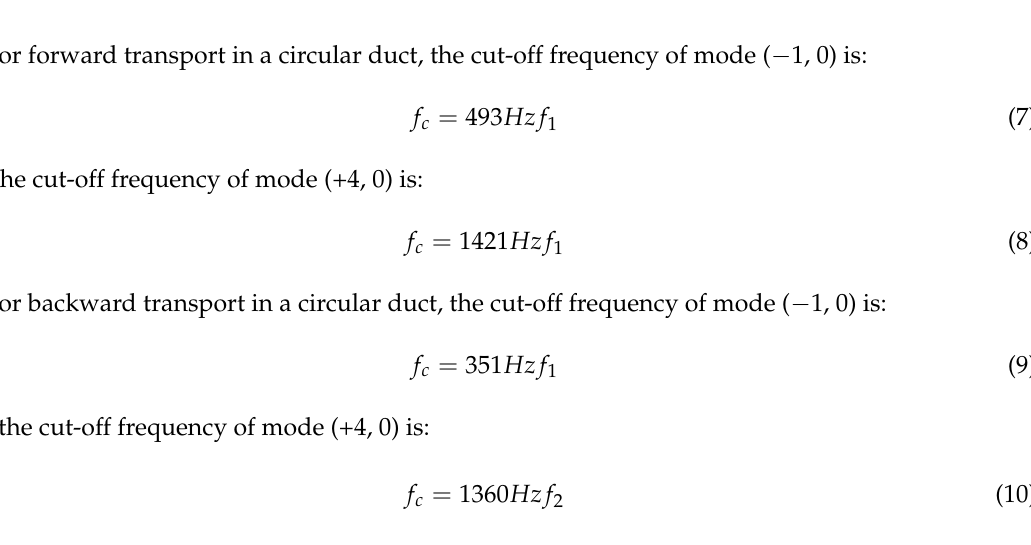
Figure 4. Acoustic frequency spectrum.